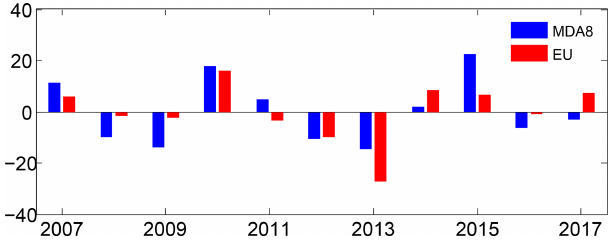
Figure 8. The variation in the JJA mean observational SDZ MDA8 (µgm − 3 ; blue) and EU index (geopotential metre – gpm; red) from 2007 to